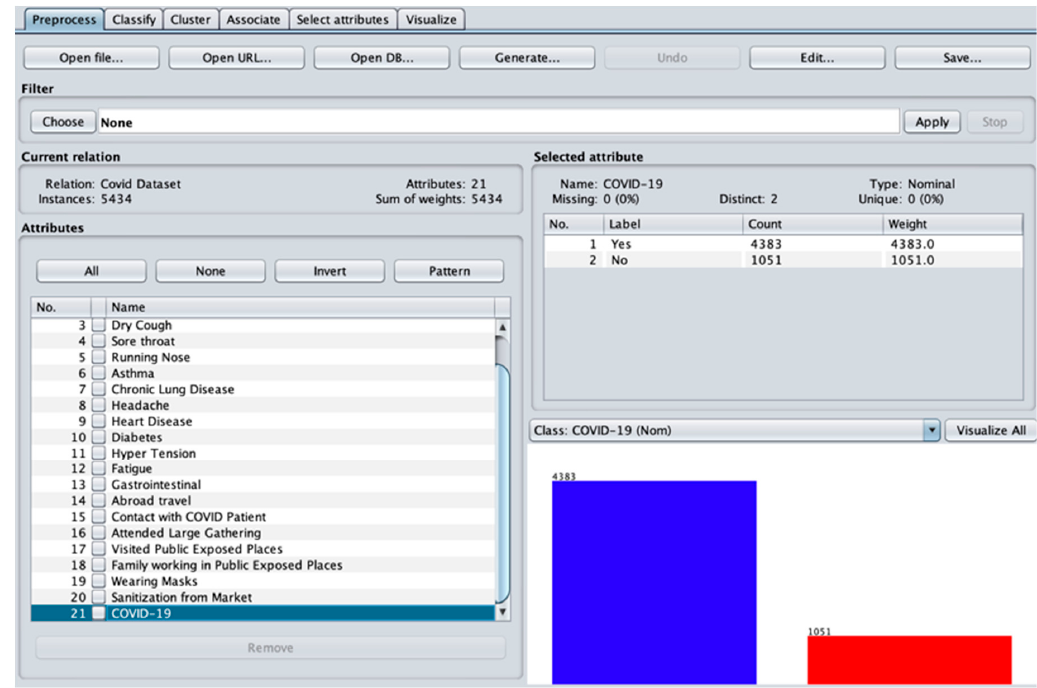
Figure 3. The Preprocess tab of WEKA Explorer showing the composition of the imported dataset and some visualizations. Users can click the Visualize All button to become more familiarized with the dataset.